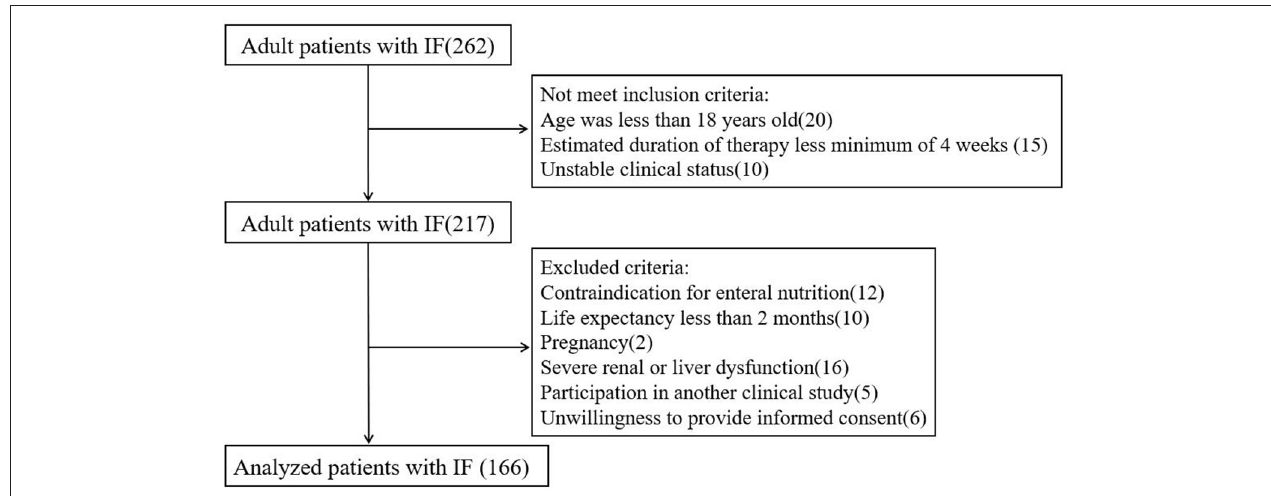
FIGURE 1 | The flow chart of study design and patient